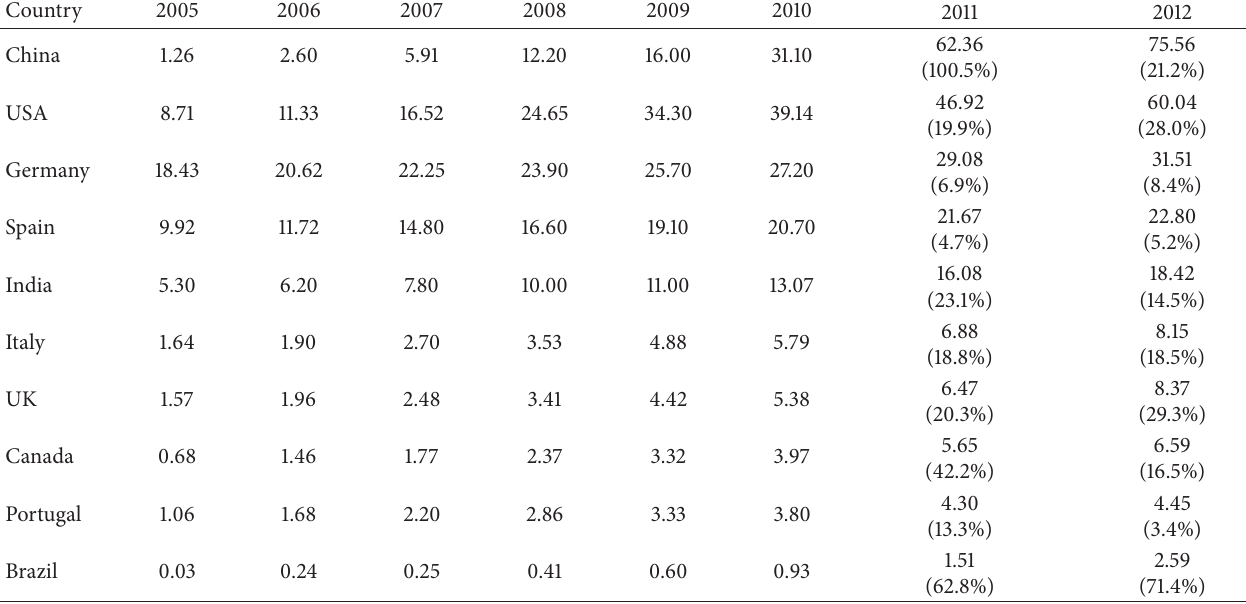
Table 1: Installed wind power per country (units in GW) of some of the biggest world producers from 2005 to 2012. The growing rates (with respect to the preceding year) corresponding to 2011 and 2012 have been also added in brackets to illustrate the present status of the wind energy market (sources: Global Wind Energy Council; US Energy Information